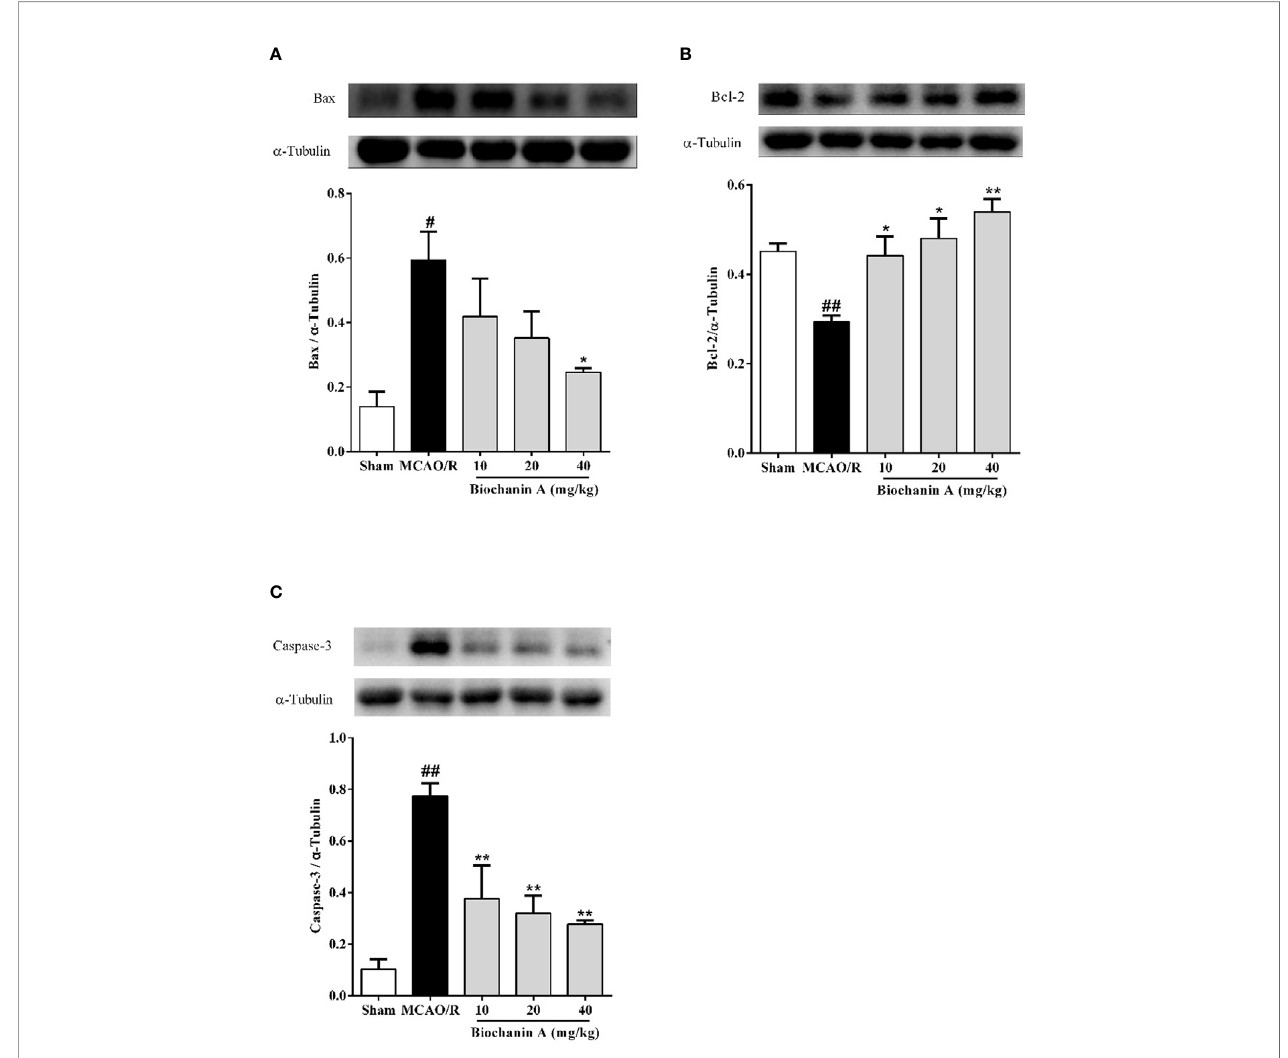
FIGURE 2 | The effects of biochanin A on apoptosis in the cerebral cortical penumbra following MCAO/R in rats. The protein expressions of Bax (A) , Bcl-2 (B) and Caspase-3 (C) were measured by Western blot and quanti fi ed by densitometric analyses in cerebral I/R rats. a -Tubulin were used as internal controls. Results were presented as mean ± SE, n = 3. # P < 0.05, ## P < 0.01, the MCAO/R group vs. the sham group; * P < 0.05, ** P < 0.01, vs. the MCAO/R